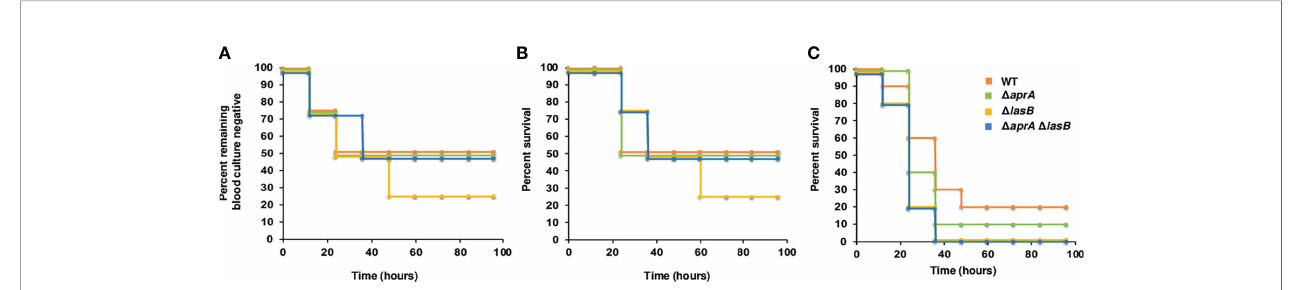
FIGURE 2 | Impact of AprA and LasB on the virulence of P. aeruginosa in a murine model of systemic infection. Analysis of time to fi rst positive blood culture in healthy mice (A) and survival curves over 4 days of healthy mice (n = 7) (B) or neutropenic mice (n = 10) (C) infected with 5 x 10 5 CFU (B) or 2 x 10 2 CFU (C) of P. aeruginosa WT strain PA14 (orange), or its derived isogenic mutants PA14 D aprA (green), PA14 D lasB (yellow) and PA14 D aprA D lasB (blue). The time to fi rst positive culture and the difference in survival between the groups were not signi fi cantly different by log rank